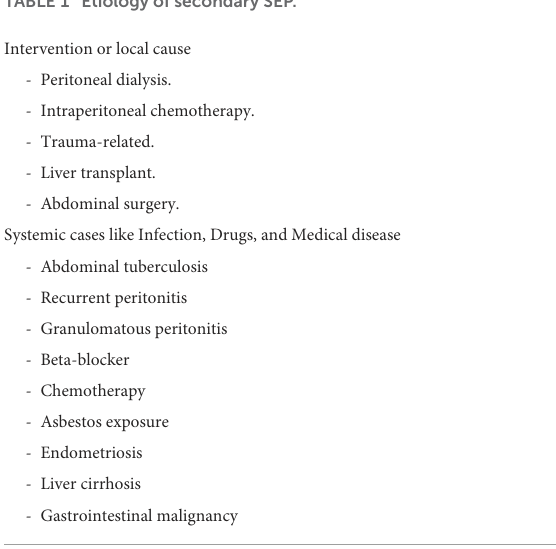
TABLE 1 Etiology of secondary